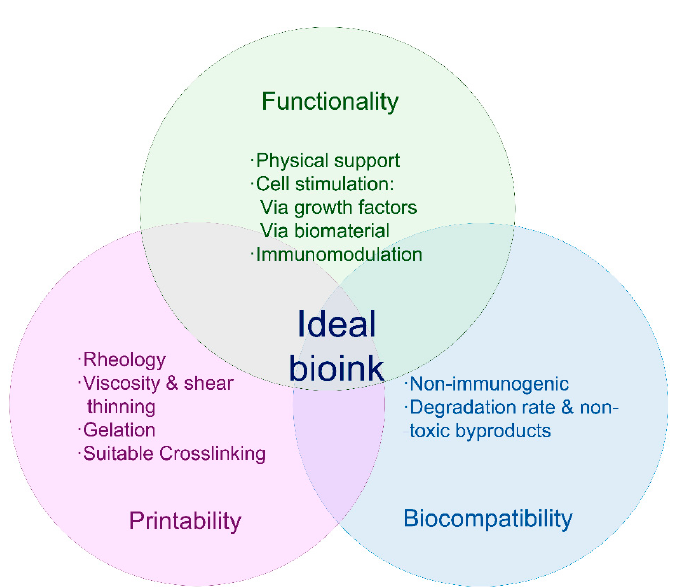
Figure 2. Requirements for bioinks. The ideal bioink must present the characteristics described in the figure above, and it should be suitable for the bioprinting device to be used, biocompatible and actively aid tissue reconstitution.